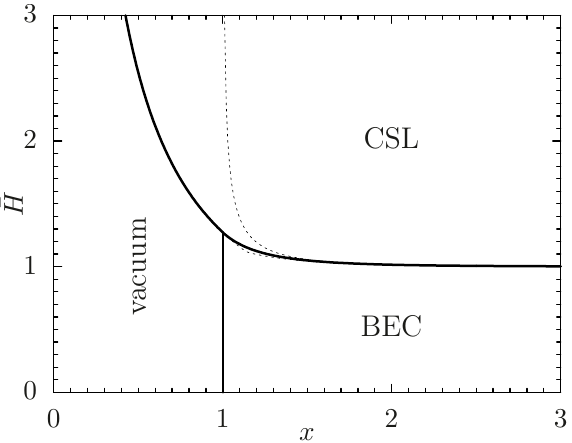
Figure 1 . Phase diagram of the EFT, and thus also of the class of (pseudo)real QCD-like theories considered in this paper, as a function of the dimensionless magnetic (cid:12)eld and chemical potential. The (cid:12)gure is adapted from ref. [21]. The solid lines indicate phase transitions. The dashed lines indicate the spinodal curves of the (cid:12)rst-order transition between the BEC and CSL phases, derived in section